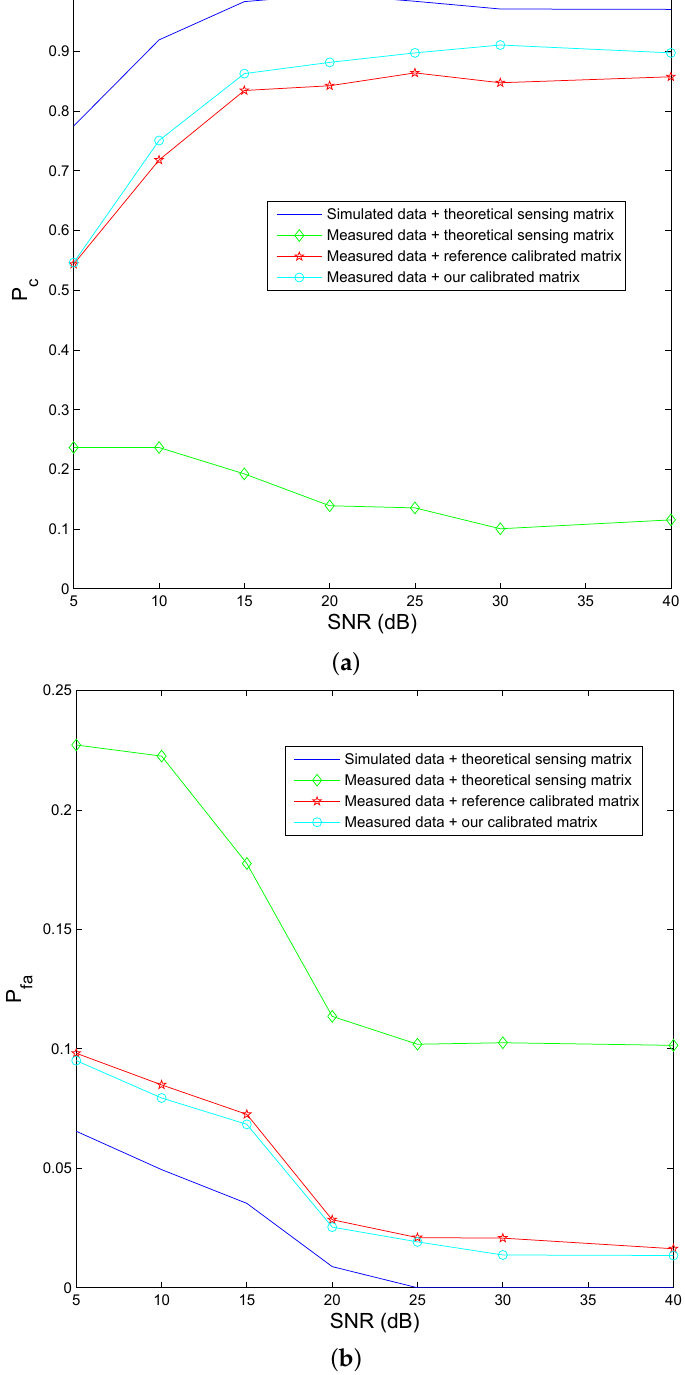
Figure 15. Correct reconstruction and false alarm rates in function of SNRs. ( a ) Correct reconstruction rate. ( b ) False alarm